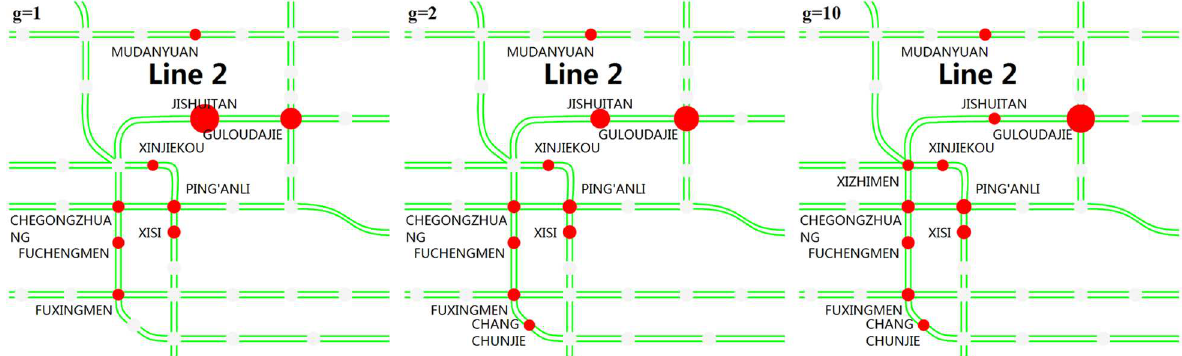
Fig 18. The main stations that passengers choose as their alternative origin stations after JISHUITAN station is closed. The red circles represent the alternativeorigin stations, including the closed JISHUITAN station. The size of each circle representsthe number of passengers who choose that station, and a larger radius indicatesrelativelymore